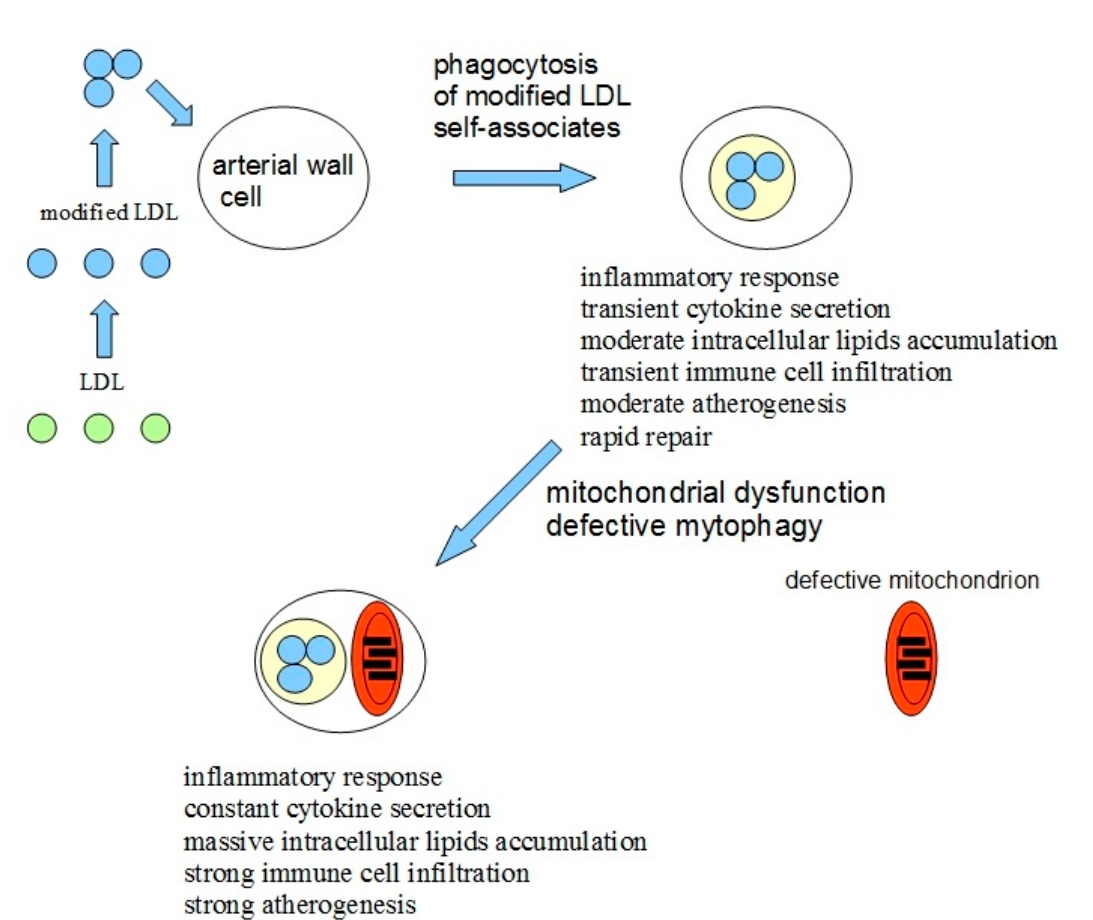
Figure 1. The model of atherosclerosis development due to chronic inflammation induced by a combination of recognition errors of modified low-density lipoproteins (LDLs) as pathogens and impaired mitophagy. Modified LDLs form self- associates and are identified by arterial cells as pathogens. After phagocytosis of LDL associates, a moderate inflammatory response is activated, leading to moderate intracellular lipid accumulation and moderate atherogenesis and the damage can still be repaired. However, in case of impaired mitophagy due to mitochondrial mutations, the inflammatory response, once being activated by modified LDL, does not stop and the inflammation becomes uncontrollable, leading to massive intracellular lipids accumulation, infiltration of immune cells, and strong atherogenesis. Modified and adapted from [15].